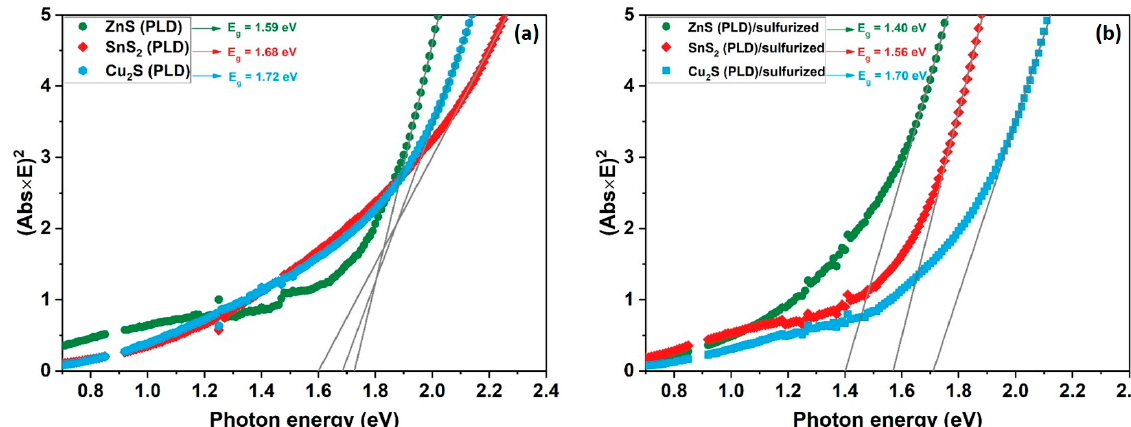
Figure 6. Tauc plot of the ( a ) as-deposited and ( b ) sulfurized CZTS thin films.